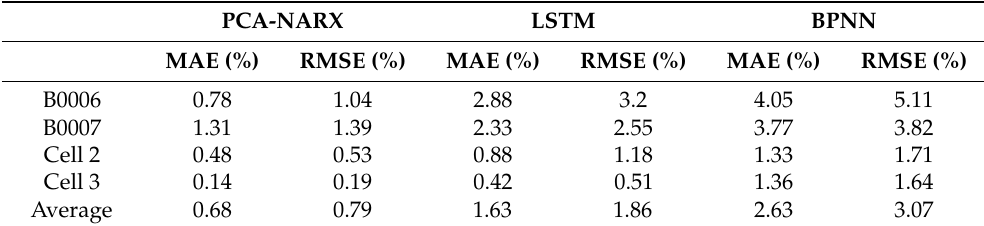
Figure 8. ( a ) Comparison of SOH estimation curves of Cell 2 battery; ( b ) Errors of SOH estimation of Cell 2 battery; ( c ) Comparison of SOH estimation curves of Cell 3 battery; ( d ) Errors of SOH estimation of Cell 3 battery. Table 4. Summary of MAE and RMSE of different algorithms.